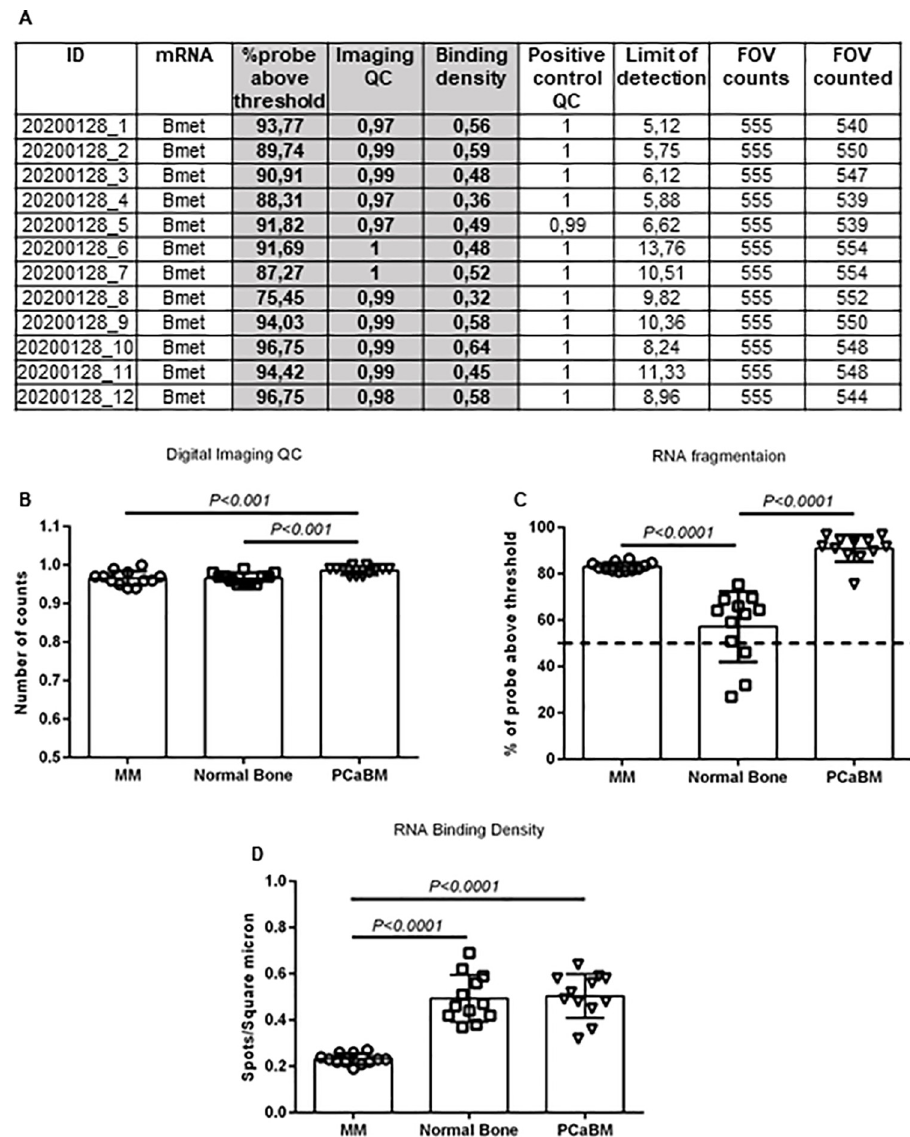
Fig 5. Digital QC analysis of mRNA yield from DFFPE of MM, normal bone and PCaBM tissue using NanoString TM technology. (A) Representative data output of QC nSolver ™ analyses for mRNA analyses from DFFPE of PCaBM. (B) Scatter-Bar graph representing digital imaging QC nSolver ™ analysis (% of fields of view) of mRNA extracted from DFFPE of MM, normal bone and PCaBM tissue provided by NanoString TM . p < 0 . 001 for comparison, n = 12 for in each group. Data were analyzed by 1-way ANOVA test and shown as means ± SD. (C) Scatter-Bar graph representing mRNA fragmentation by QC nSolver ™ analysis. % of probes with more than 300 nucleotides (nt) from DFFPE of MM, normal bone and PCaBM tissue provided by NanoString TM . Dashed line indicates the threshold value (50%) for minimum percentage of probes (greater than 300 nt). p < 0 . 0001 for comparison n = 12 for in each group. Data were analyzed by 1-way ANOVA test and shown as means ± SD. (D) Scatter-Bar plot indicating mRNA binding density using QC nSolver ™ analysis from DFFPE of MM, normal bone and PCaBM tissue provided by NanoString TM . Dashed line indicates the threshold value for minimum amount of RNA binding density (0.1–1.8 spots per square micron) according to NanoString TM . p < 0 . 0001 for comparison n = 12 for in each group. Data were analyzed by 1-way ANOVA test and shown as means ±